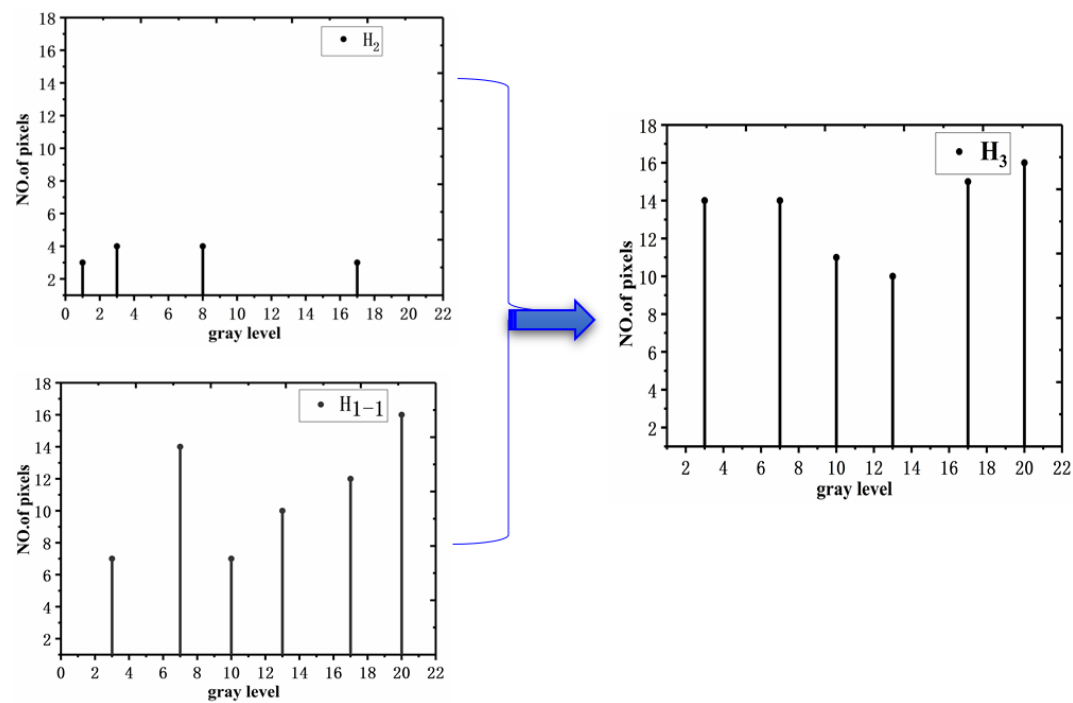
Figure 4. Mapping process of the restricted histogram.